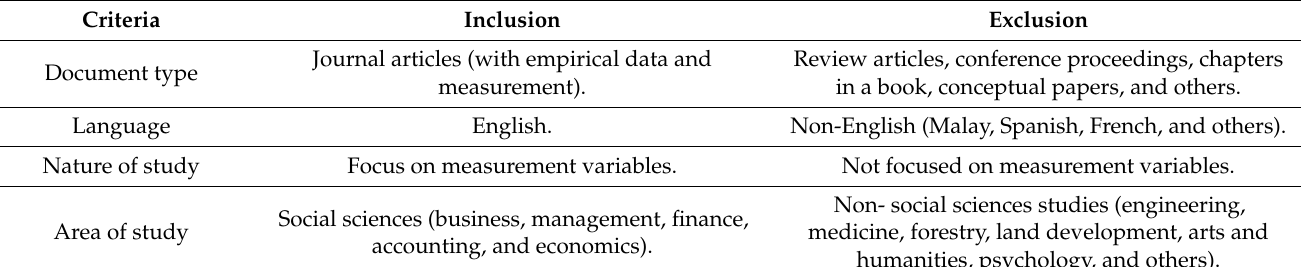
Table 2. Inclusion and exclusion